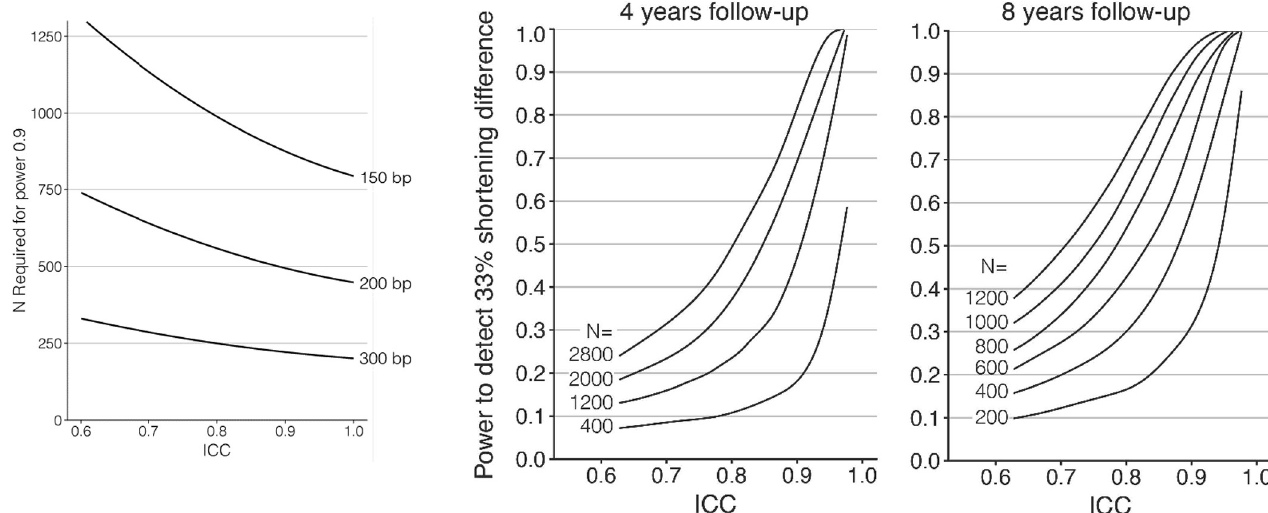
Fig 5. A. The sample size required to test effect sizes of 150, 200 and 300 bp with a t-test with a power of 0.9, as a function of measurement error as expressed in the ICC. Calculations assumed a realistic (true) standard deviation of 650 bp and power analysis was done using G � Power [57]. N is the combined n of the two groups to be compared and was assumed to be equally distributed among the two groups. B, C. Power to detect a 33% change of telomere shortening rate, up or down, with p < 0.05 relative to a baseline shortening rate of 25 bp/year. D. Four-year follow-up period. E. Eight-year follow-up period. Power was calculated for sample sizes as shown (200–2800), equally divided over the two levels of telomere shortening rate. Baseline telomere shortening was simulated assuming a Poisson distribution with mean/variance of 25, and population SD of telomere length was maintained at 0.65 kb at both time points.